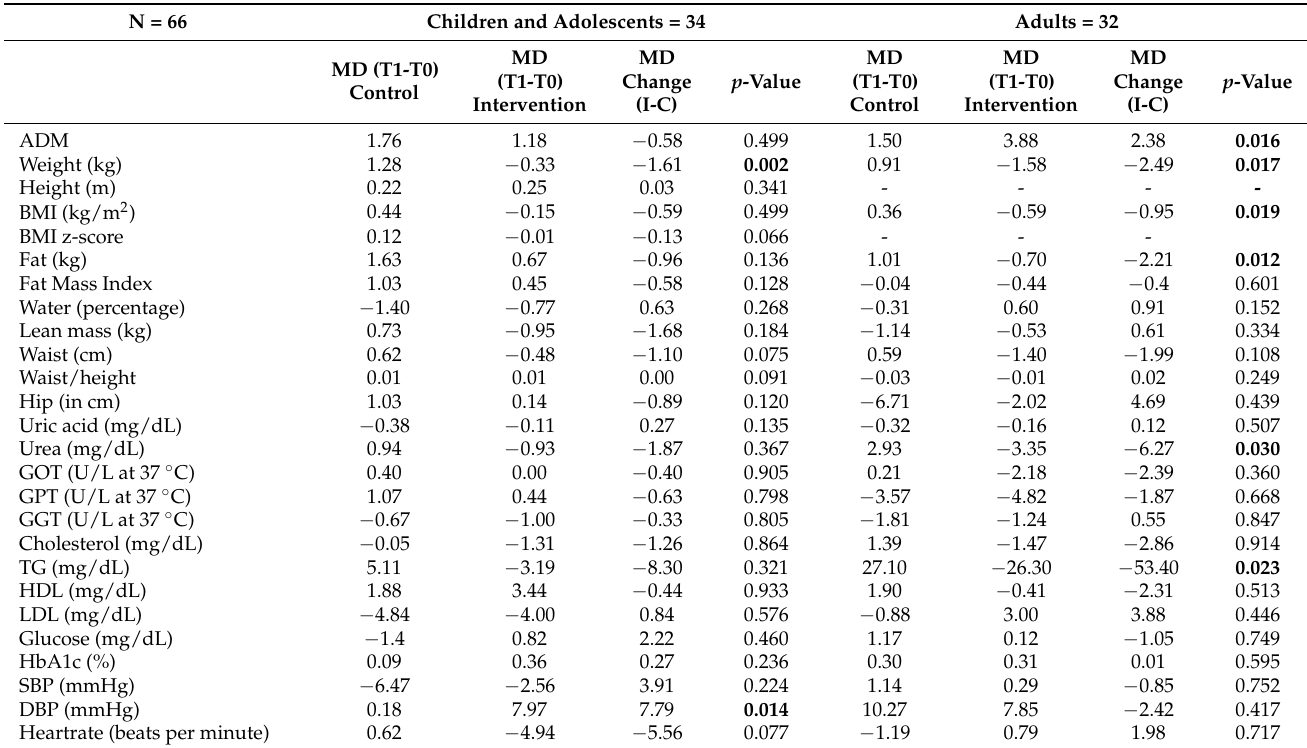
Table 4. Mean differences comparing a 10-week educational program for participants in the interven- tion and the control group divided by children and adolescents vs. adults.